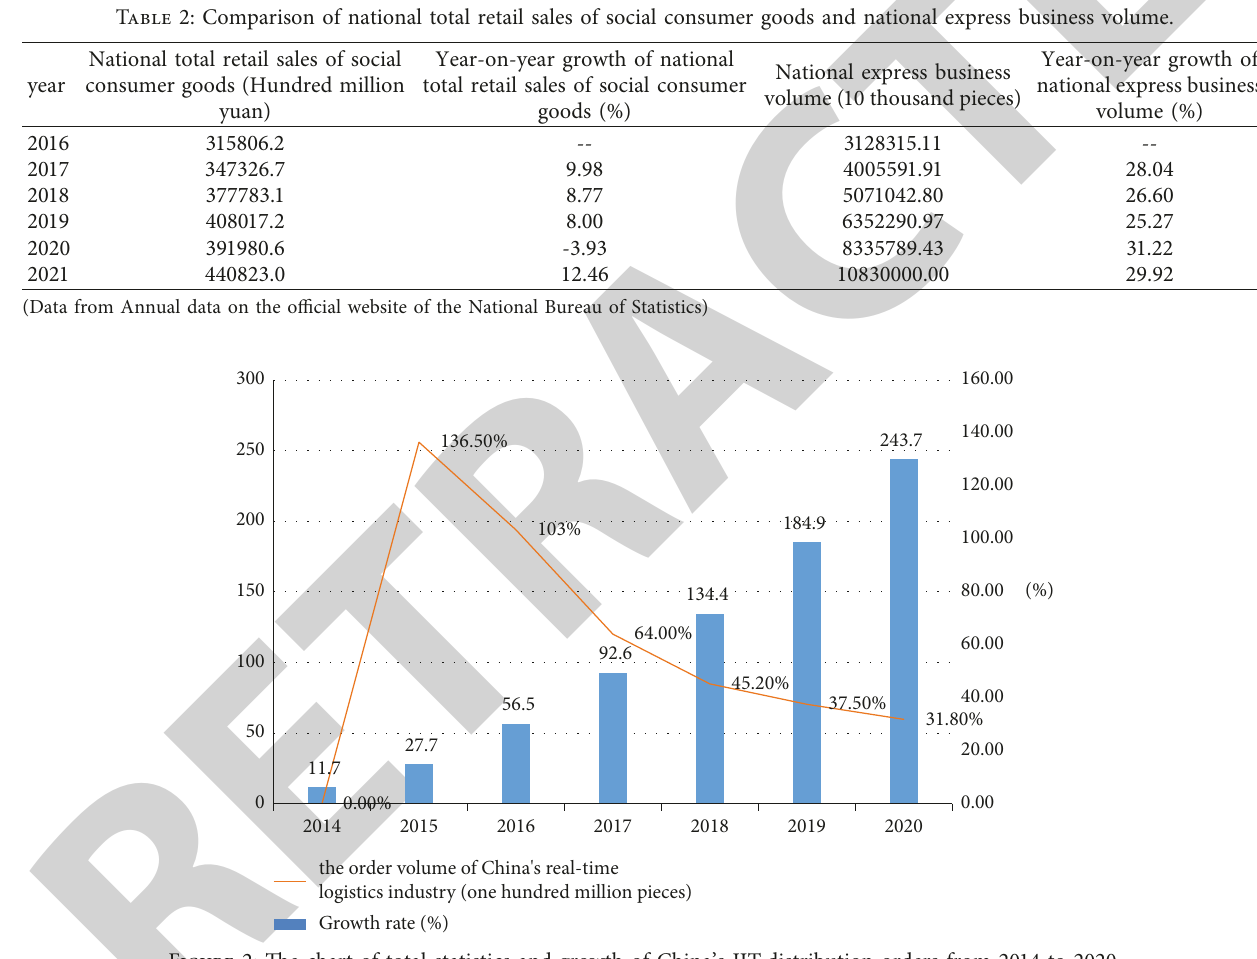
Figure 2: The chart of total statistics and growth of China’s JIT distribution orders from 2014 to